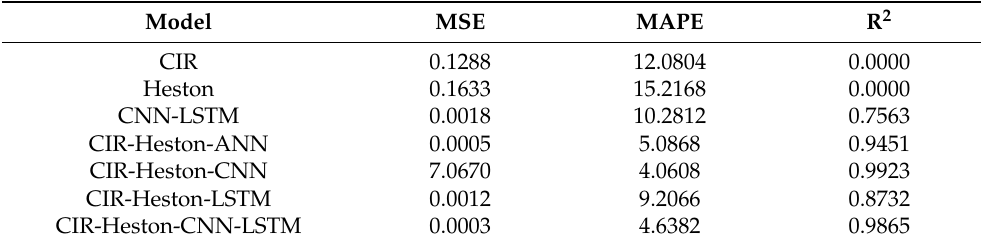
Figure 8. Comparison of real and predicted results of CSI 300ETF put options. Table 6. Comparison of the prediction accuracy between the different